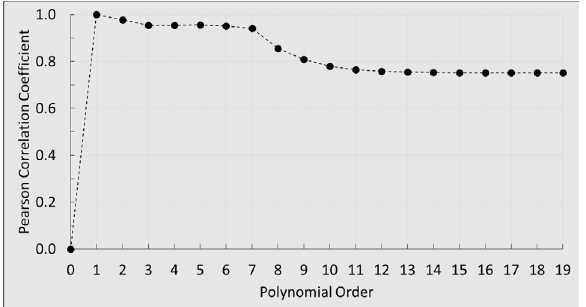
Figure 14. PCC between precipitations and modelled velocities regarding polynomial order in modelling of precipitations and velocities for target point 6 (Figure